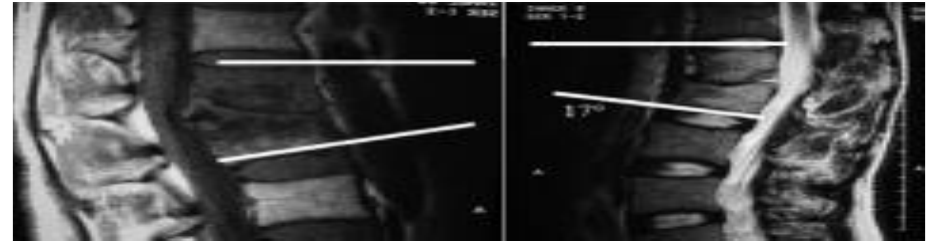
Figure (4).. Pretreatment (left) and posttreatment (right) MR images obtained in a 44-year-old man. Left: Image showing upper lumbar (L-1) Pott disease with a Cobb angle of 15°. Right: